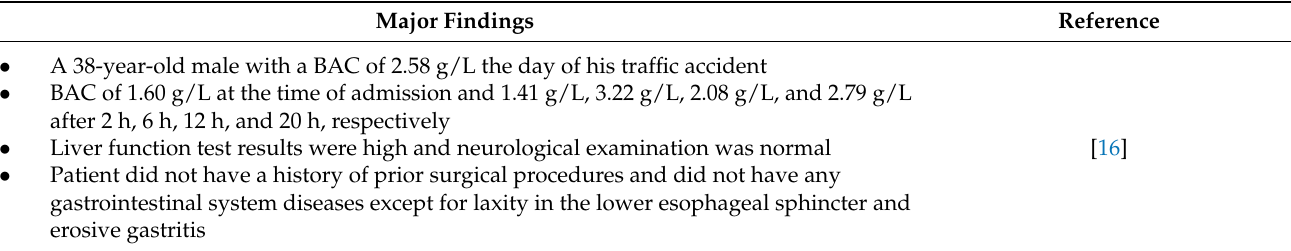
Table 1. Major findings of case reports on